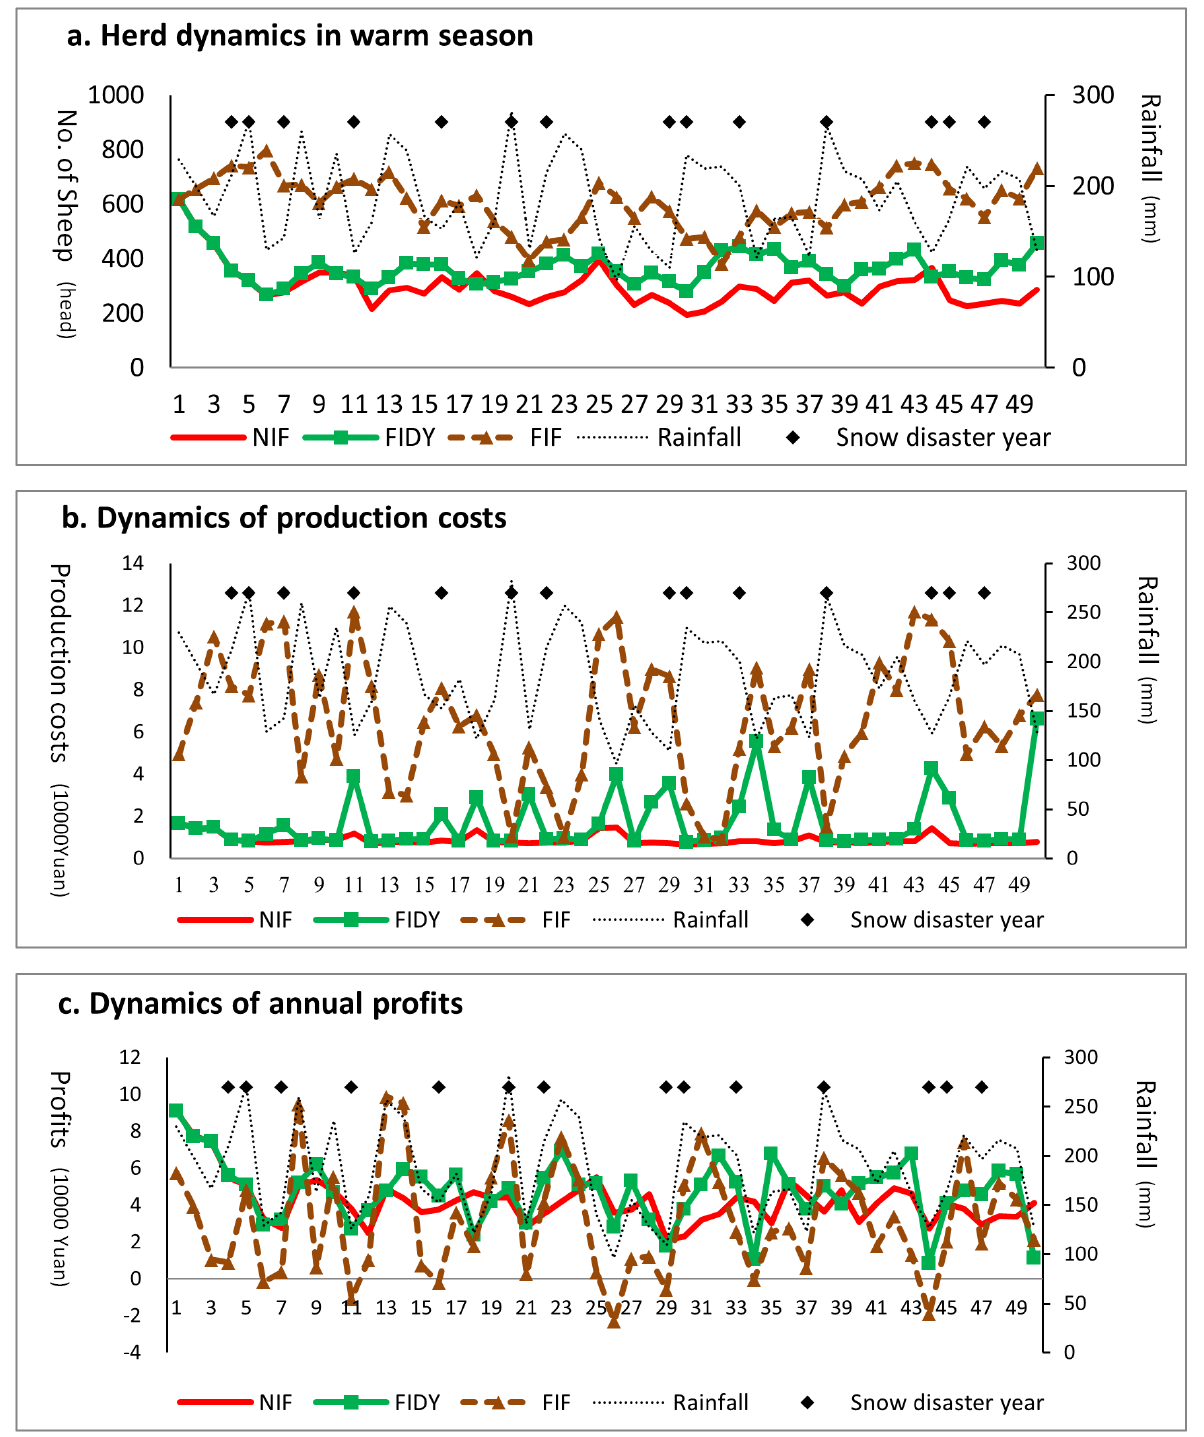
Fig. 6 . A simulation example of herd size, production costs, and annual profit dynamics over time in one simulation when livestock price was two times that of baseline scenario. NIF - no import of fodder, IFDY - import of fodder only in disaster years, FIF - frequent import of